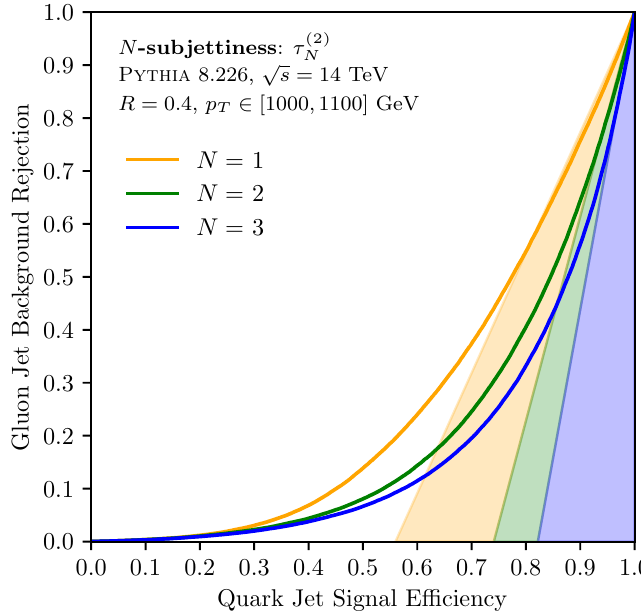
Figure 10. The ROC curves for N -subjettiness observables with (cid:12) = 2, together with the predic- tions for their asymptotic behavior. The predictions are shown as shaded regions that are predicted to match the slope of the ROC curve in the high quark-e(cid:14)ciency region. We also predict the slope of the ROC curve to approach zero in the low quark-e(cid:14)ciency region. There is good agreement between the predictions and the observed classi(cid:12)cation